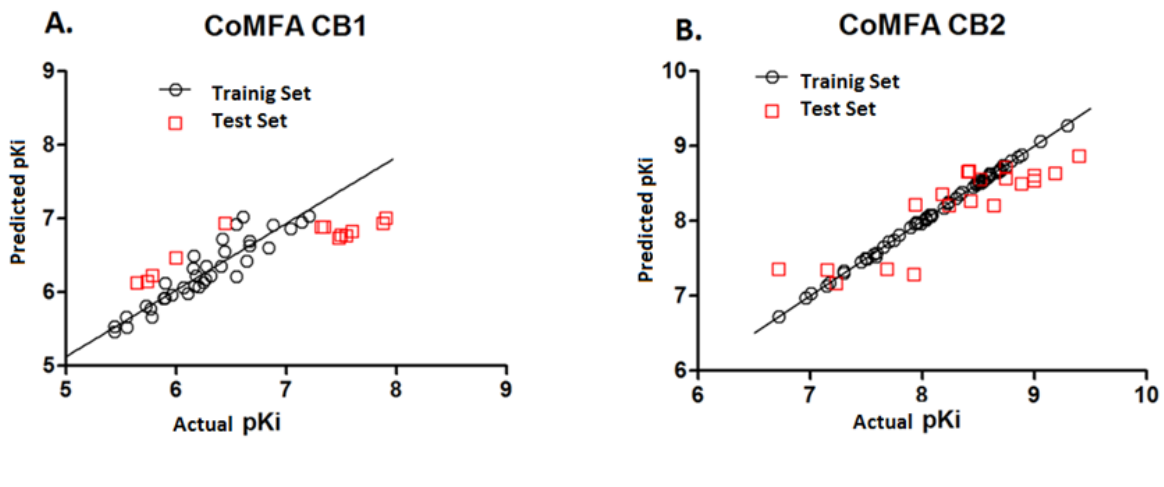
Figure 2. Experimental versus predicted activity for A . CB1 CoMFA analysis and B . CB2 CoMFA